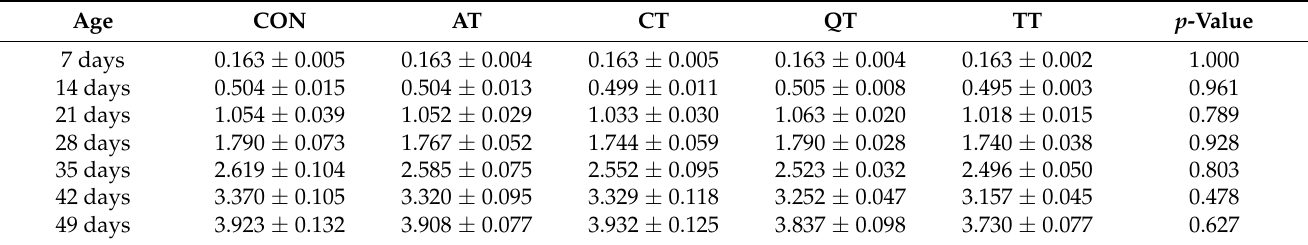
Table 2. Effects of adding different tannins to the diet on the weekly weight of broilers (kg).